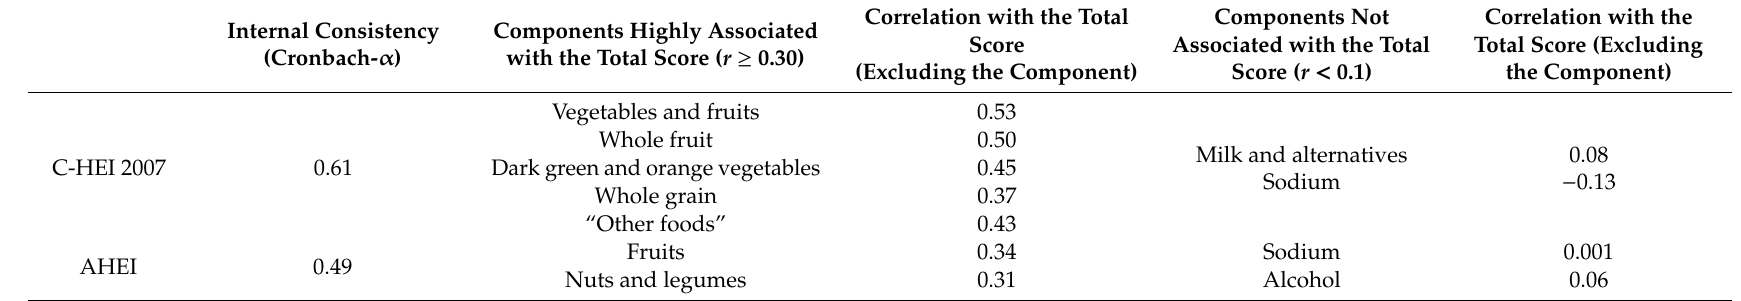
Table 2. Internal consistency (Cronbach- α ) of the Canadian Healthy Eating Index 2007 (C-HEI 2007) and the Alternative Healthy Eating Index 2010 (AHEI) ( N = 998). Internal Consistency Components Highly Associated (Cronbach- α ) with the Total Score ( r ≥ 0.30)